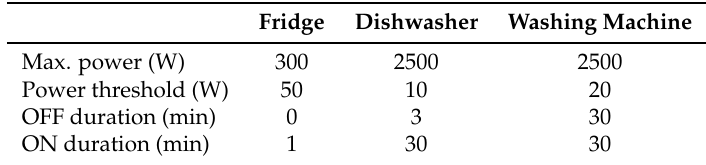
Table 2. Parameters used to derive the activation status of household appliances from measurements of the absorbed power.